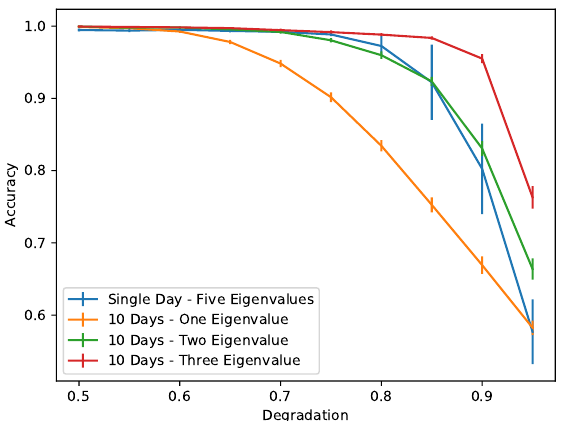
Figure 11. Comparison of the performance between networks using a single and a 10-day long MIM. A single-day MIM network performs similarly to a 10-day long MIM network that uses two natural modes.